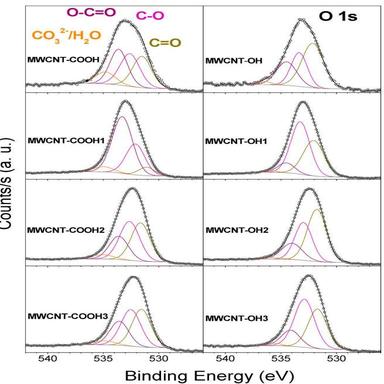
High-resolution O 1s XPS spectra of the MWCNTS along with their corresponding chemical components, named C– –O, C–O, O–C– –O, CO3 2− and H2O, in increasing binding energy order.